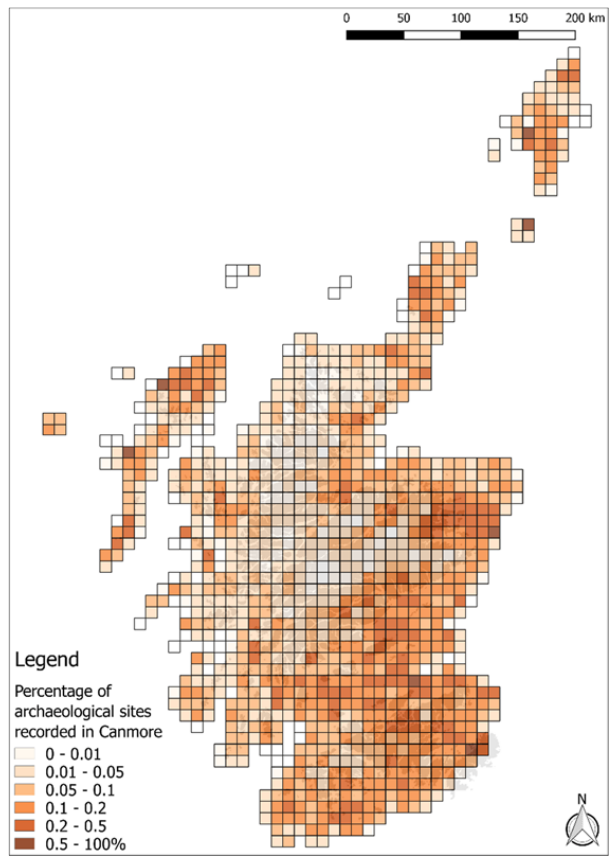
Figure 2. Map, by 10 km grid square, showing the density of archaeological records with an accuracy recorded as being within 10m. The east and southern lowlands are noticeable for having most records while the central and western highlands and islands have a noticeably lower density. Areas of intensive survey are apparent as areas of darker tones. © Historic Environment Scotland (Source: NRHE/Canmore).